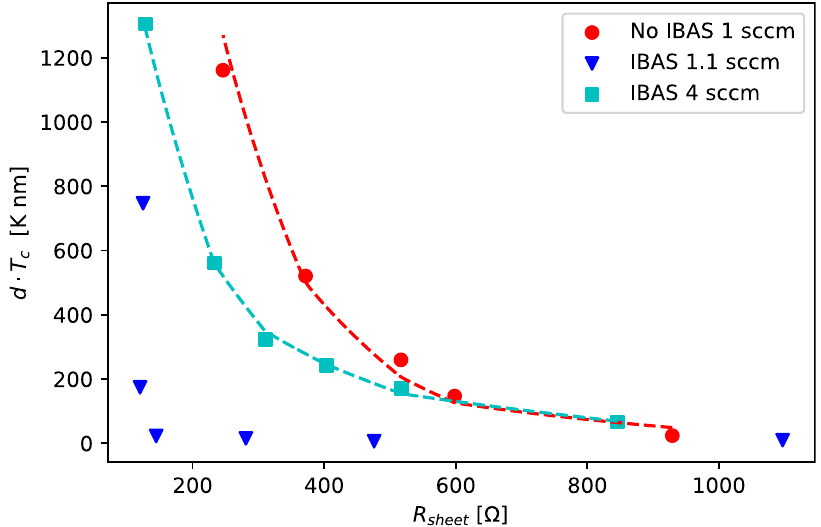
Figure 5. Dependence of superconducting T c scaled by thickness on sheet resistance for different nitrogen flows. Experimental data for 1 sccm non-IBAS films (red) and 1.1 (blue) and 4 sccm (cyan) IBAS films are shown respectively. The dashed lines are fits of Eq. (5) while the 1.1 sccm IBAS films heavily deviate from the model.